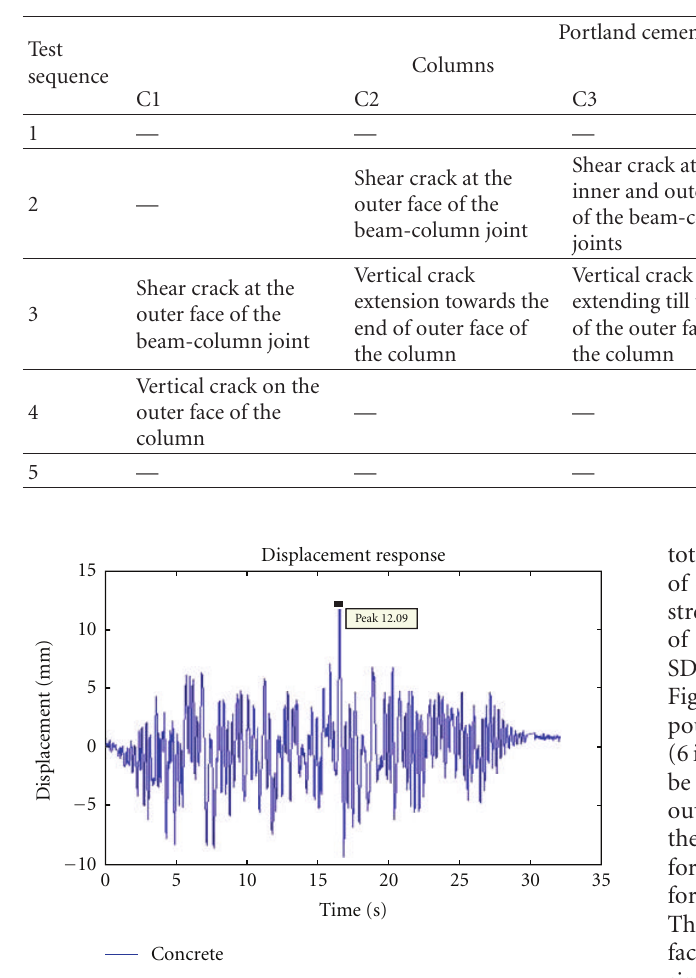
Figure 11: Displacement response of concrete frame, column after test sequence